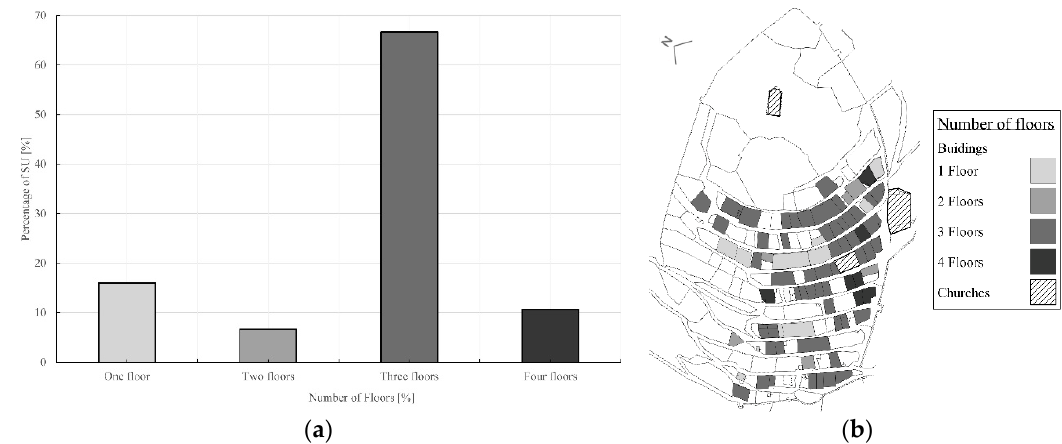
Figure 4. Histogram ( a ) and map ( b ) of the distribution of the floor number for each SU in Campi Alto di Norcia. Horizontal storeys and roof typologies.